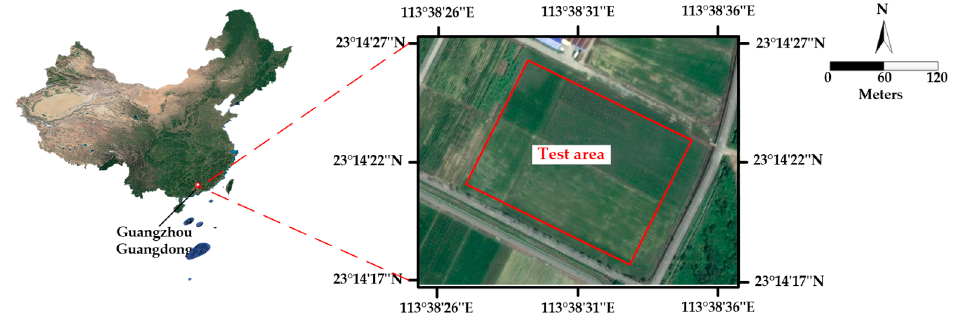
Figure 12. Location of the experimental site.